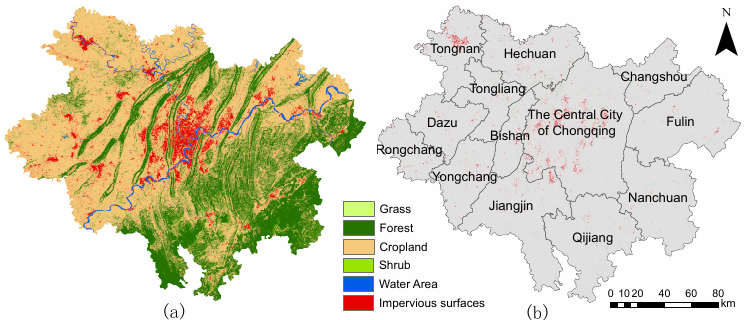
Figure 10. Simulation results of land use/cover pattern in 2025 ( a ) and multi-land use expansion from 2020 to 2025 ( b ).